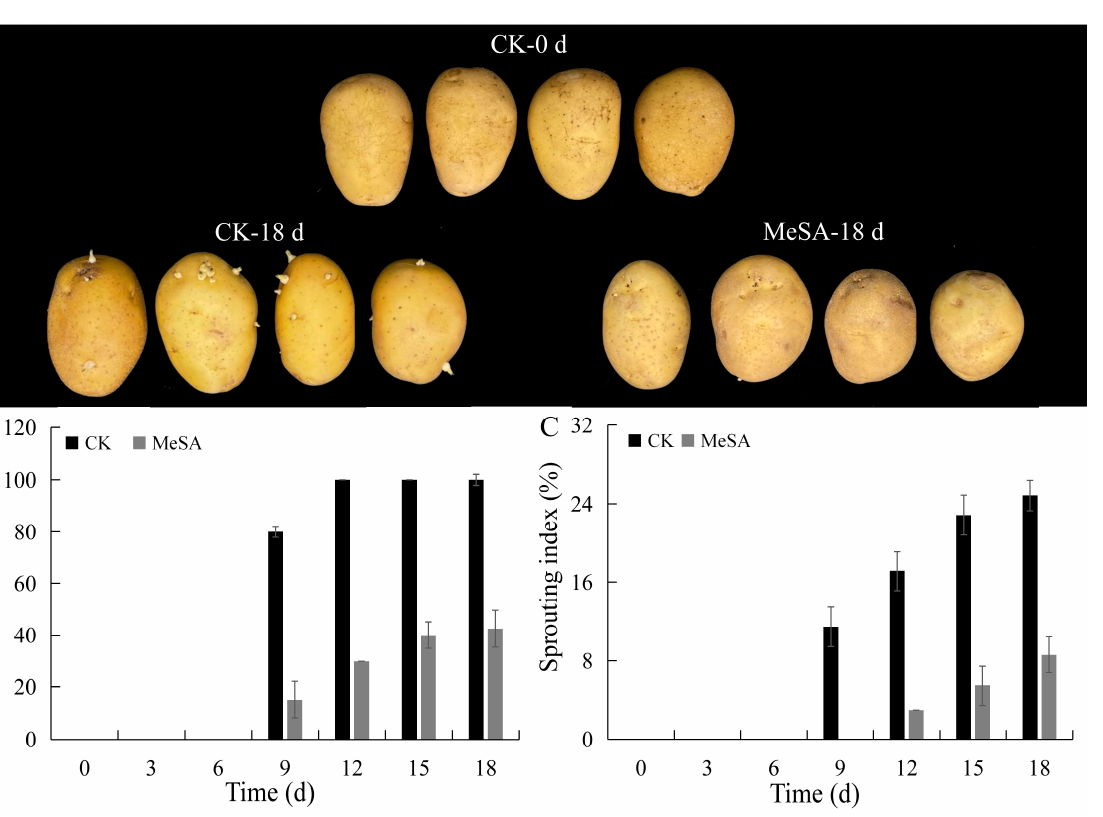
Figure 1. Effect of MeSA treatment on potato tuber sprouting ( A ), sprouting rate ( B ), and sprouting index ( C ). Each value represents mean ± standard deviation of three replicates.